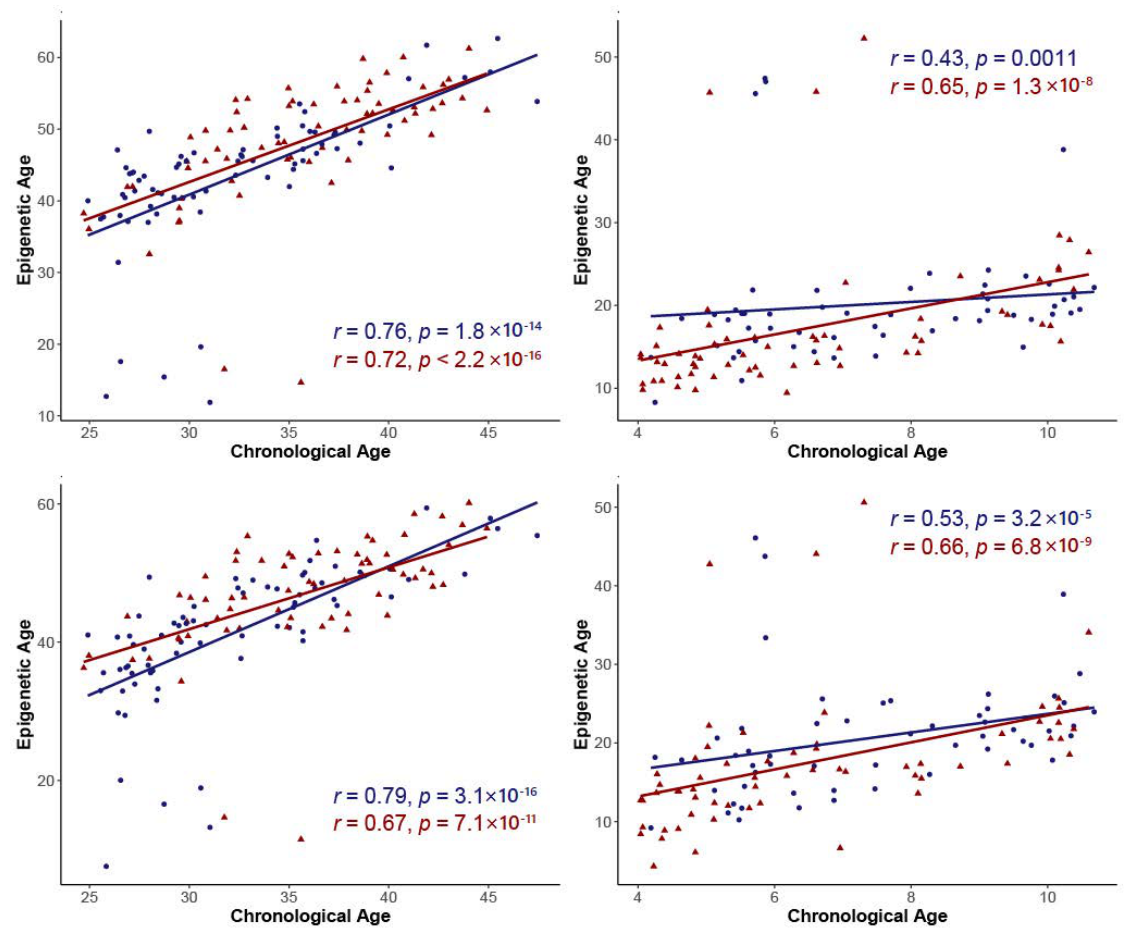
Figure 1. Correlation plots of epigenetic age and chronological age by exposure group: ( A ) Horvath clock in mothers; ( B ) Horvath clock in offspring; ( C ) Hannum clock in mothers; ( D ) Hannum clock in